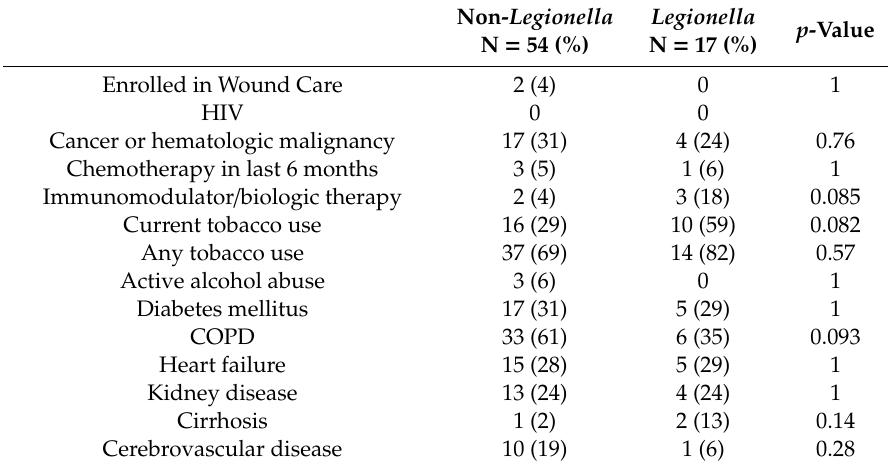
Table 2. Characteristics of Legionella and pneumonia cases. AMS: Altered Mental Status, PSI: Pneumonia Severity Index, RR: Respiratory Rate, SBP: Systolic Blood Pressure, AST: Aspartate